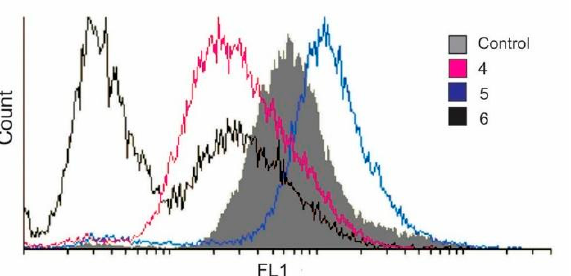
Figure 5. Compounds 4 − 6 differently affect the production of reactive oxygen and nitrogen species (ROS/RNS) in MCF-7 cells. MCF-7 cells were pre-stained with dihydrorhodamine 123 (DHR 123) and treated with 4 , 5 or 6 (IC 50 dose) for 60 h. Intracellular accumulation of ROS/RNS were measured by flow cytometry. Representative histograms from three independent experiments are shown.